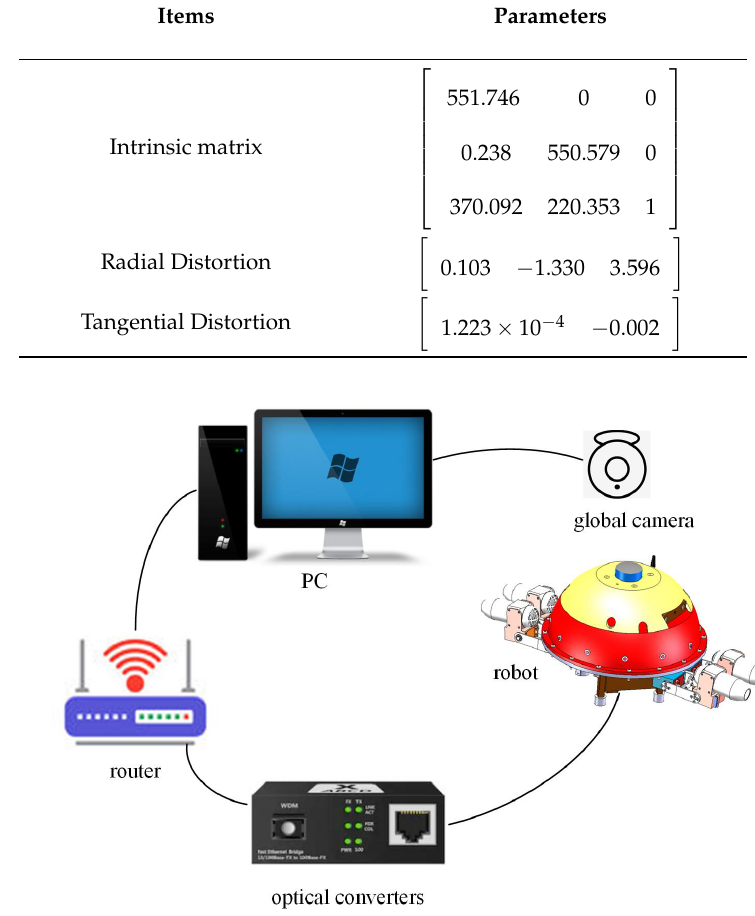
Figure 19. The information transmitting system of the